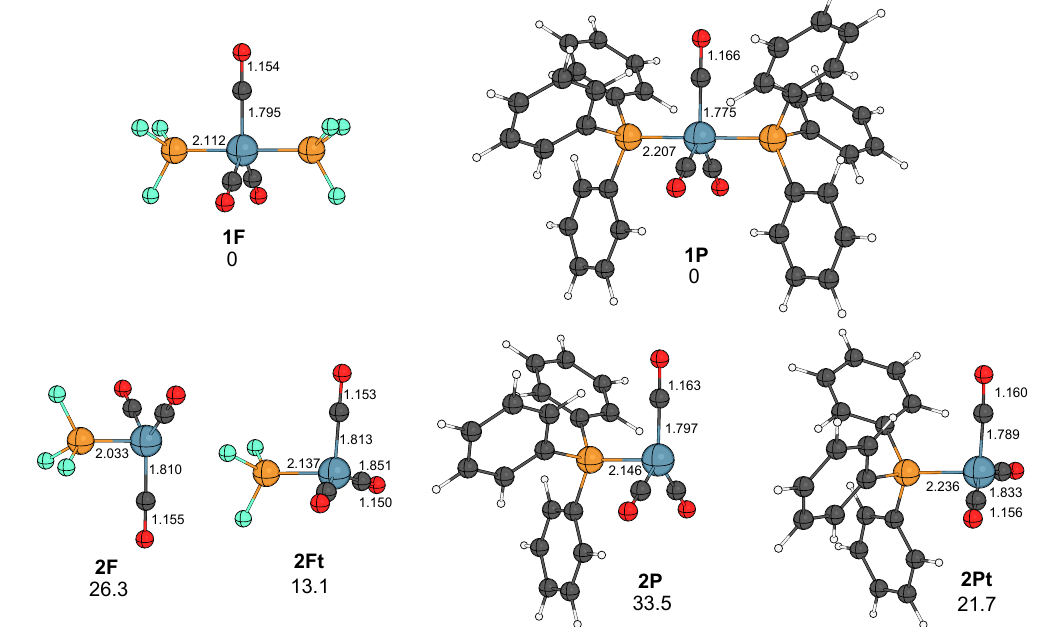
Figure 1. Computed structures of coordinatively saturated Fe(CO) 3 (P) 2 and unsaturated Fe(CO) 3 (P) types of complexes. Gibbs free energy values are given in kcal/mol and bond lengths are in Å. The free energy values are relative to 1F (for the phosphorus-trifluoride-containing complexes) and 1P (for the triphenylphosphine-containing